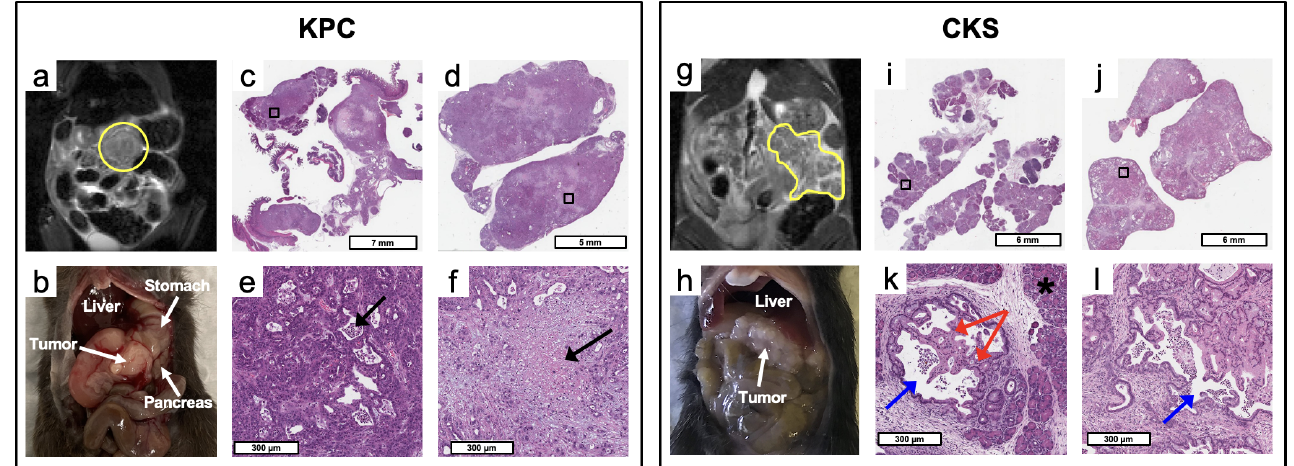
Figure 1. MRI, gross dissection, and pathological features of KPC and CKS tumors. ( a ) T2W coronal MRI view of a KPC mouse, ( b ) gross dissection, ( c ) H&E stained micrograph of a relatively small and ( d ) large KPC tumor specimen. ( e ) is the magnified region labeled in ( c ), showing the glandular structure (black arrow) formed by surrounding adenocarcinoma cells. ( f ) is the magnified necrotic tumor region (black arrow) labeled in ( d ). ( g ) T2W coronal MRI view of a CKS mouse, ( h ) gross dissection, ( i ) H&E stained micrograph of a relatively small and ( j ) large CKS tumor specimen. ( k ) is the magnified labeled region labeled in ( i ), revealing folding and papillary architecture formed by tumor cells (red arrow) growing inside the lumen (blue arrow) of an expanded pancreatic duct and residual pancreas (*). ( l ) is the magnified labeled region in ( j ), showing the lumen (blue arrow) of a duct expanded by neoplastic ductal epithelial